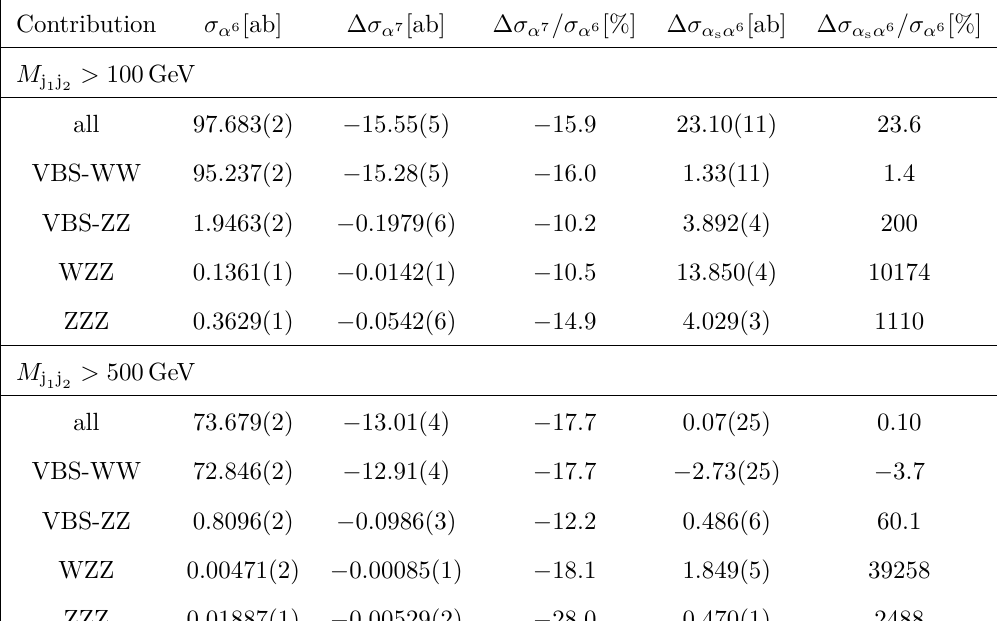
Table 3. Contributions of partonic channels to fiducial cross sections for pp → e + e − µ + µ − jj + X at 13 TeV CM energy. Contributions at orders O relative to the corresponding O of the table are for the inclusive setup, those in the lower part are for the VBS setup. The digits in parentheses indicate the integration